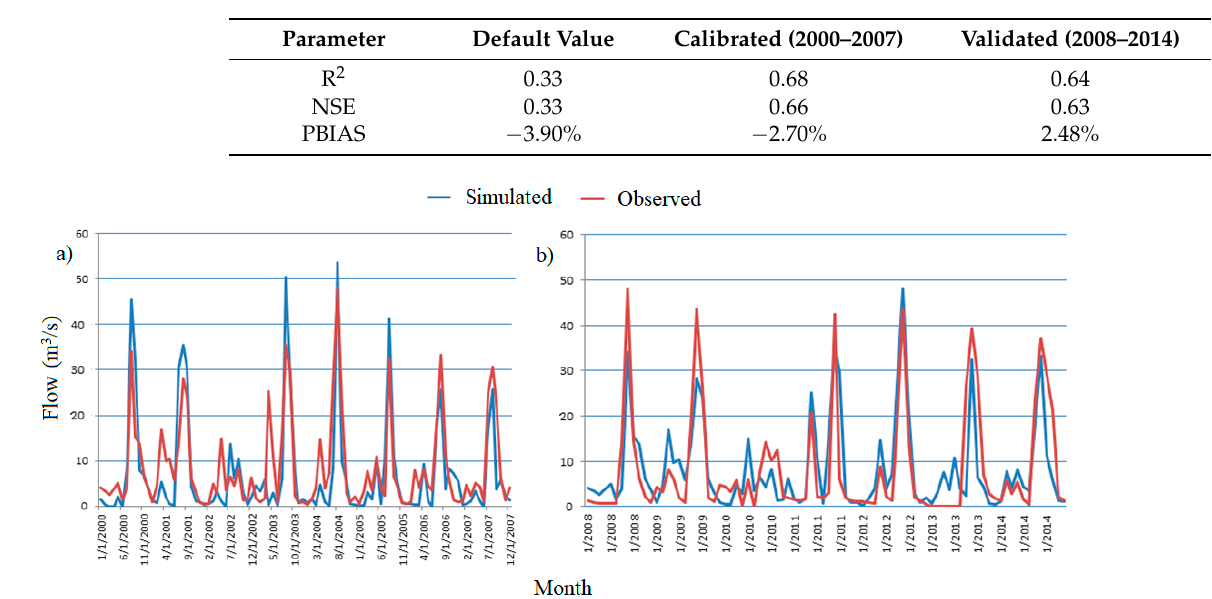
Table 4. Table showing the default values before calibration and the calibration and validation statistics for the monthly observed and simulated stream flow.